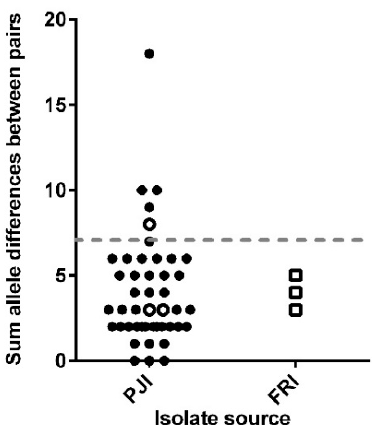
Figure 4. Molecular diversity among the 86 isolates from 41 patients, with the graph showing the sum of allele differences in 841 core genes. Line designates the patient pairs with ≥ 7 allele differences, and open symbols represent patients with more than 3 isolates.